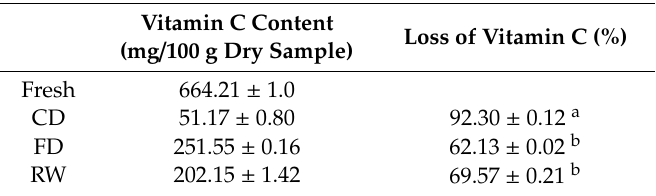
Table 3. Loss of vitamin C from guava pulp dried by the CD, FD and RW methods. Di ff erent letters indicate significantly di ff erence between di ff erent treatments ( p <